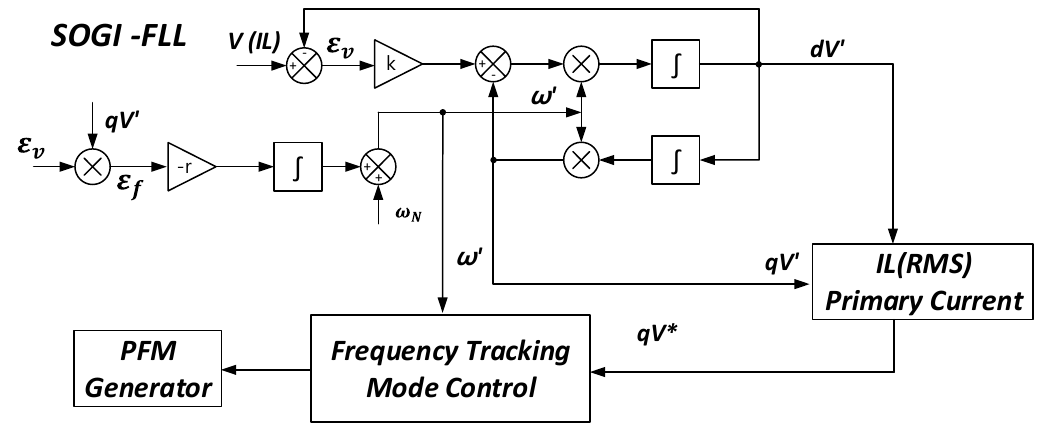
Figure 7. Block diagram of the overall proposed frequency-tracking algorithm.